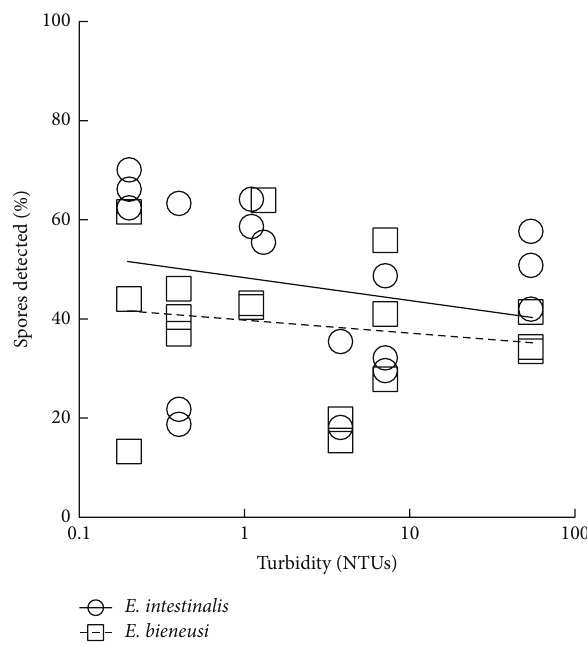
Figure 4: Detection efficiency of E. intestinalis and E. bieneusi by CFD + qPCR with increasing